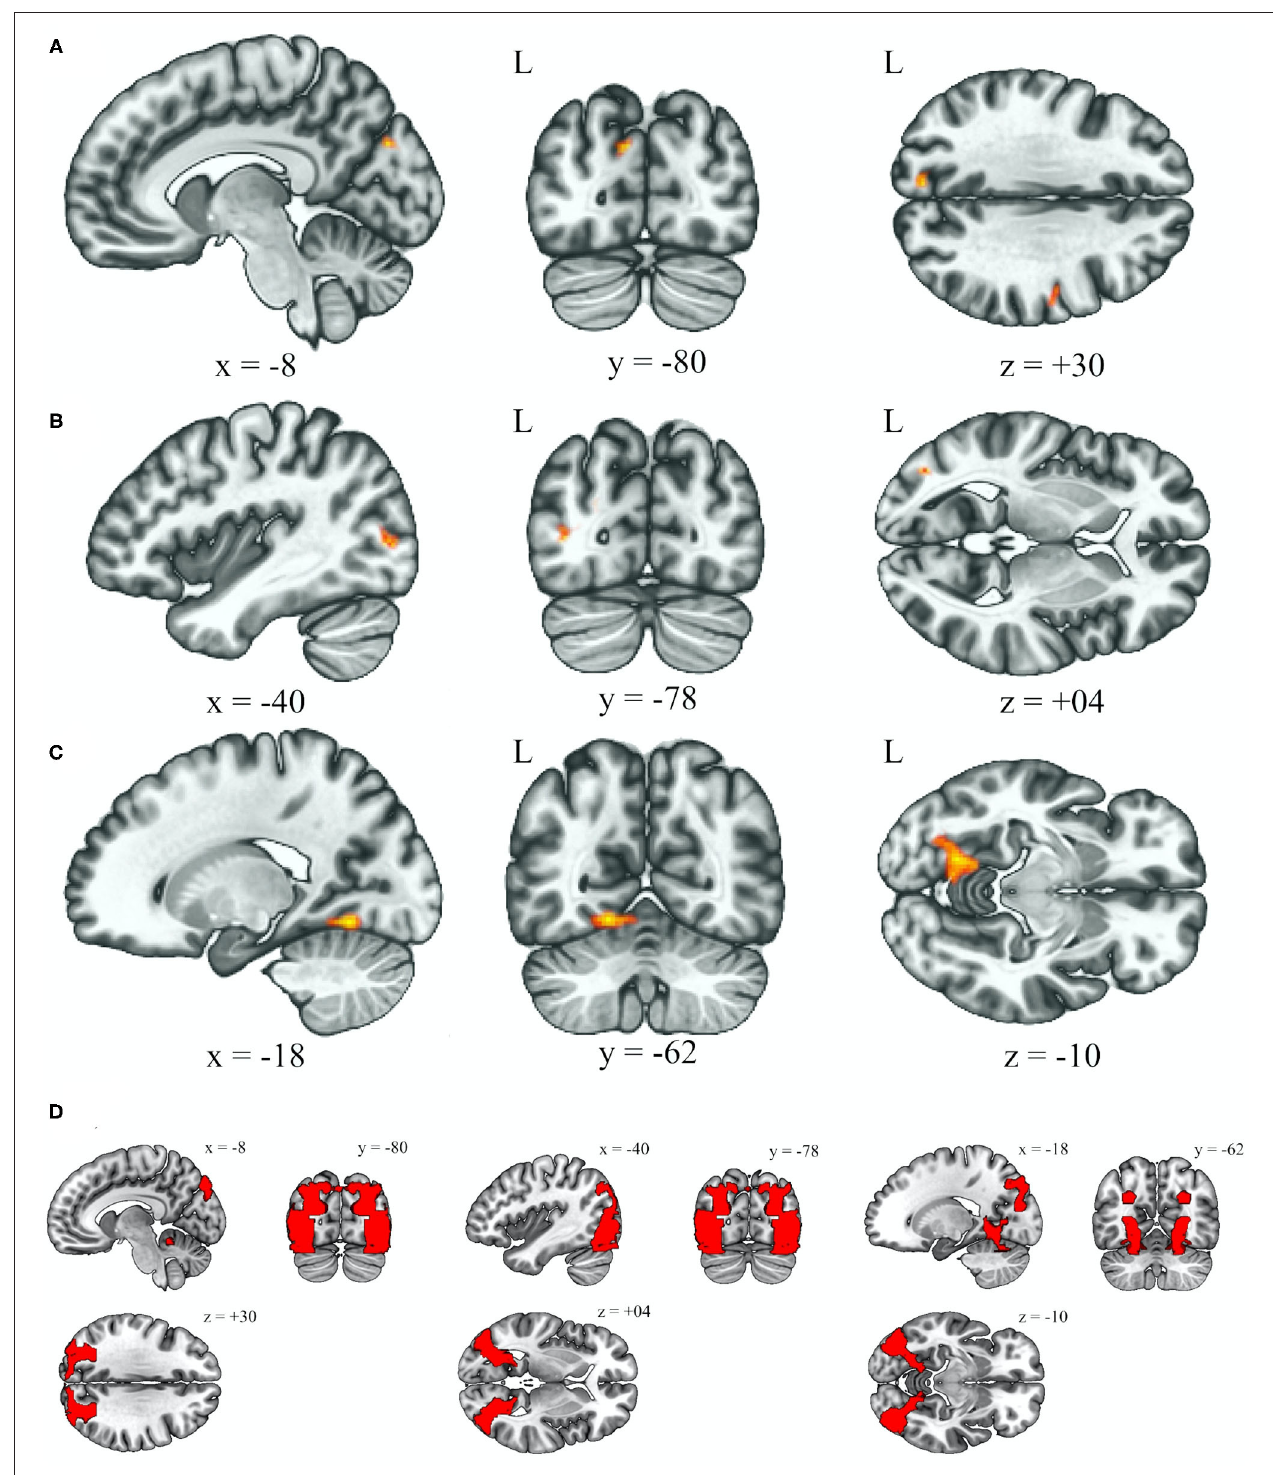
FIGURE 1 | Increased functional connectivity with the anterior cerebellum as the seed ROI ( p < 0.05, p-FDR-corrected) over the left occipital lobe (BA19), in the BSP group vs. HC group (A) , HFS group vs. HC group (B) , and the effect of cold detection threshold of the QTT over the lower extremities in all subjects (C) . Illustrations of BA19 in corresponding coordinates (x, y, z), left ( − 8, − 80, + 30), middle ( − 40, − 78, + 04), right ( − 18, − 62, − 10) (D) . L, left; ROI, region of interest; BA, Broadmann area; BSP, blepharospasm; HC, healthy control; HFS, hemifacial spasm; QTT, quantitative thermal test.